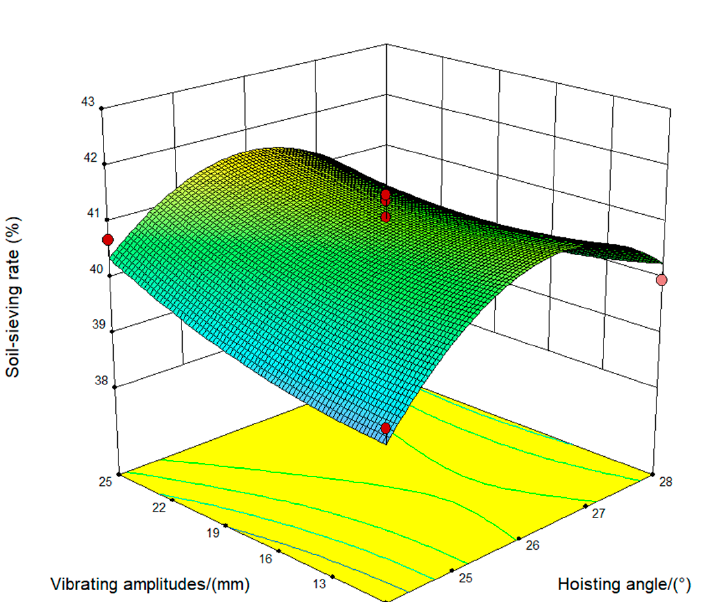
Figure 9. Response surface diagram of vibrating amplitudes and hoisting angle.